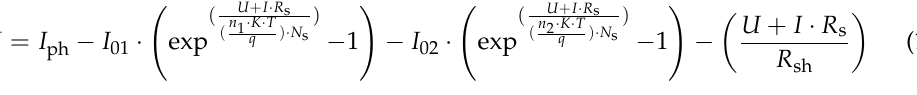
Figure 3. Model setup: PV/T collectors in combination with a TEST model created in the Matlab/Simulink software package.